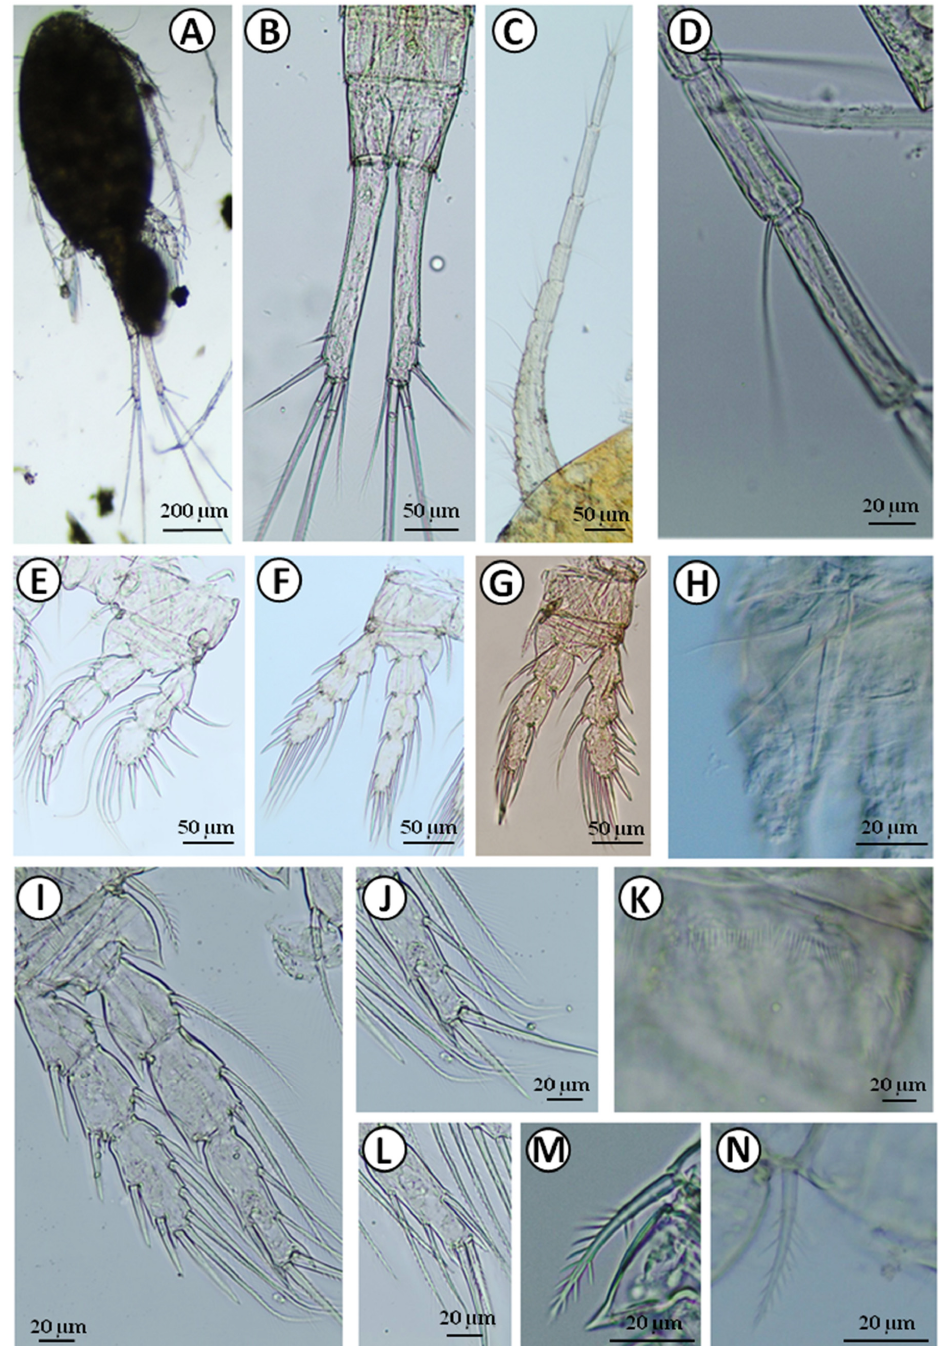
Figure 4. Eucyclops serrulatus : A —body; B —furcal branches; C —antennule; D —hyaline membrane on the 10th and 11th segments of the antennule; E —P1; F —P2; G —P3; H —P5; I —P4; J , L —last segment of P4 endopodite; K —P4 coxopodite; M , N —coxal spine of P4.